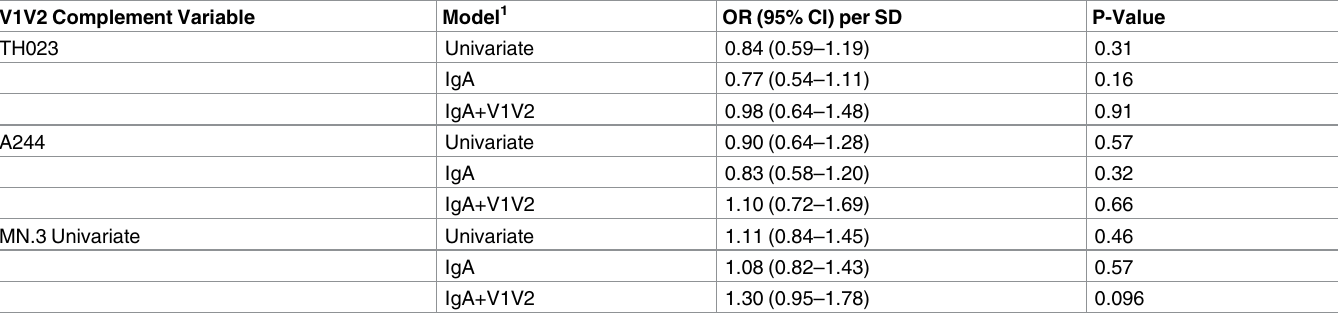
Table 2. Results testing the correlation of quantitative complement activity readouts with HIV-1 infection.